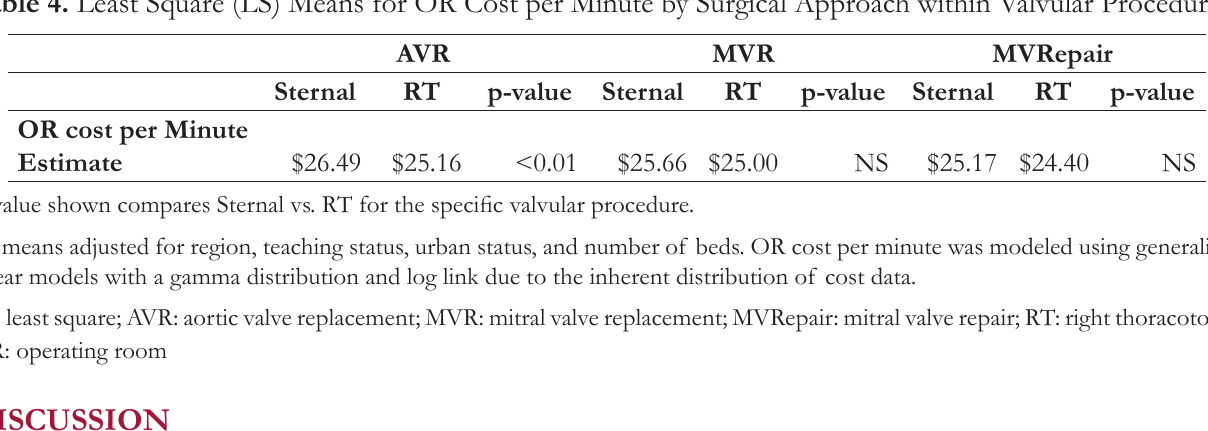
Table 4. Least Square (LS) Means for OR Cost per Minute by Surgical Approach within Valvular Procedure